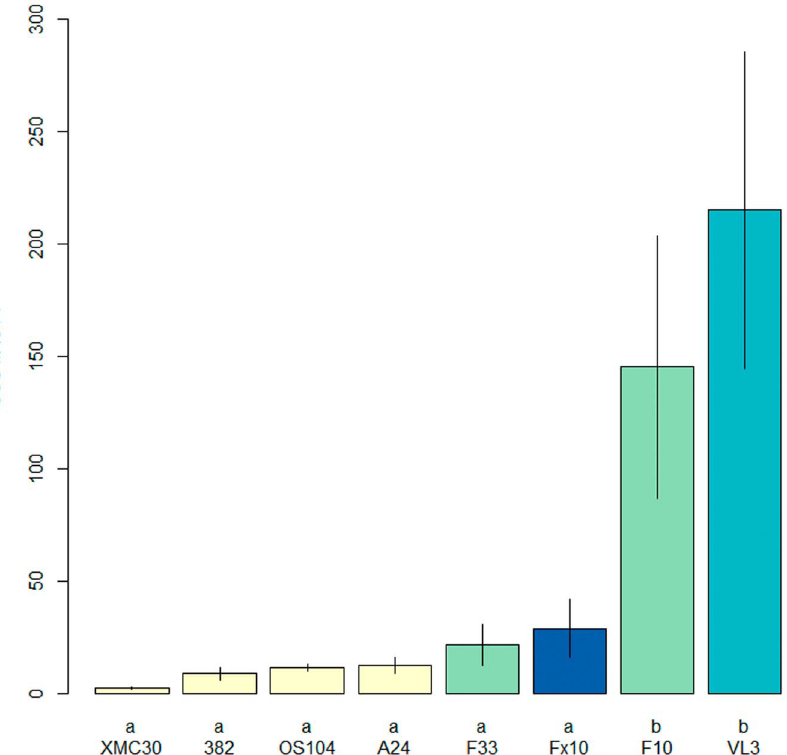
Figure 5. Expression level of SSU1 at mid-alcoholic fermentation according to the chromosome XVI forms. The SSU1 expression level was measured during the alcoholic fermentation. Yeast cultures were sampled at 40 g/L of CO 2 at the end of the growth phase. Bar plots represent the mean and the standard error of three independent extractions for eight strains (XMC30, 382, 0S104, A24, F33, Fx10, VL3). The chromosome XVI forms of the strains are coded by grey tones: Yellow, light green, dark green and dark blue represent respectively strains with only nt-XVI, only VIII-t- XVI, only XV-XVI and with both VIII-t-XVI and XV-t-XVI forms. The letters on the bottom of strain name represent the statistical groups computed by Duncan analysis of the one-way ANOVA model used.